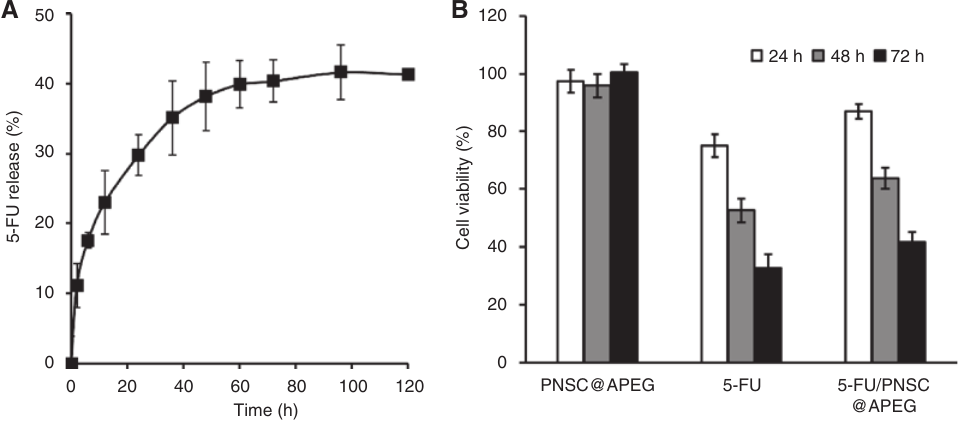
Figure 7: (A) In vitro release profiles of 5-fluorouracil (5-FU) from adamantylamine-polyethylene glycol-functioned cyclodextrin-porous nano- silica (PNSC@APEG) (■). (B) Toxicity profiles of samples against NIH3T3 cells by the MTT assay. Experiments were performed three times and the results are expressed as mean ± S.E. of triplicates of one representative experiment. The cells were incubated with PNSC@APEG (100 μ g/ml), 5-FU (1 μ g/ml), and 5-FU/PNSC@APEG at concentration of 1 μ g/ml equivalents